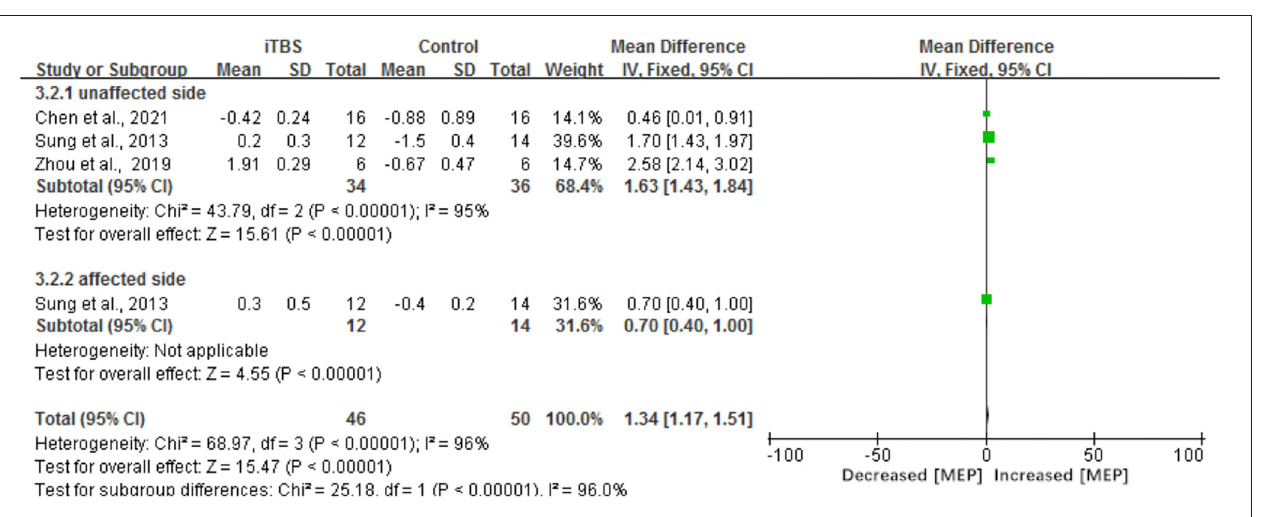
FIGURE 8 | Forest plots of the pooled results on the latency of